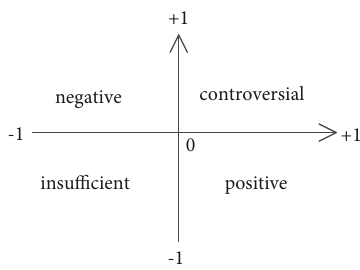
Figure 1: Coordinate distribution of four types of